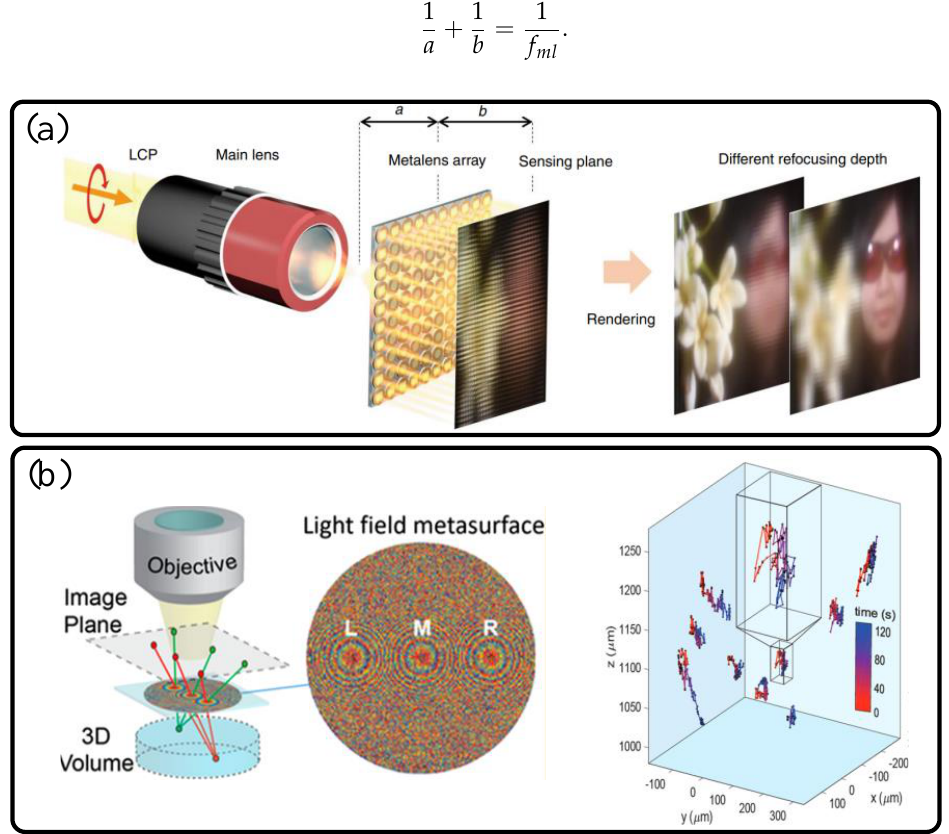
Figure 7. ( a ) Spatial [34] and ( b ) phase [35] multiplexed light field metasurfaces for 3D sensing applications. ( a ) Scheme of light field imaging for depth sensing using dielectric micro-metalens array. ( b ) Scheme of multi-foci light field silicon metalens for real-time 3D tracking of micro-beads with enhanced resolution ( left ), and experimental result ( right ). ( a ) Reprinted with permission from [34] Copyright 2019 Springer Nature. ( b ) Reprinted with permission from [35] Copyright 2019 American Chemical Society.